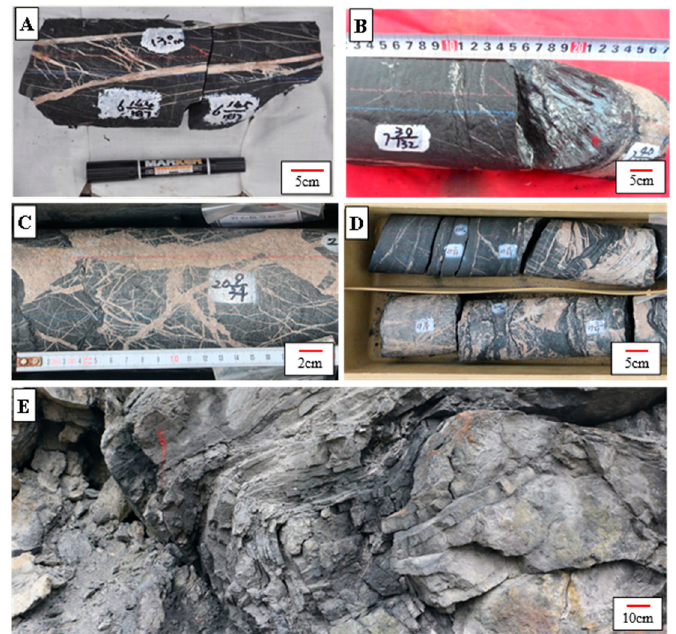
Figure 6. Detachment layers developed at the bottom of the Lower Cambrian in cores and field profiles in the Southeast Chongqing region and Xiuwu Basin. ( A ) Cores from the Niutitang Formation in the Youye-1 well, 3820 m; ( B ) cores from the Niutitang Formation in the Youye-1 well, 3827 m; ( C ) cores from the Wangyinpu Formation in the Jiangye-1 well, 2671 m; ( D ) cores from the Wangyinpu Formation in the Jiangye-2 well, 3130 m; ( E ) The Wangyinpu Formation in the Pukou profile. The well locations can be seen in Figure 1.